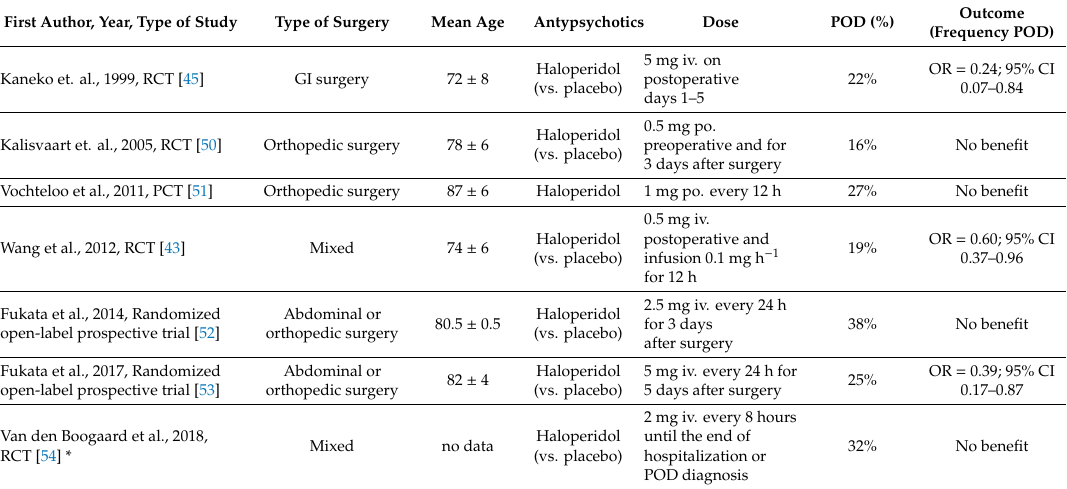
Table 3. Studies evaluating the e ff ectiveness of haloperidol in the prevention of